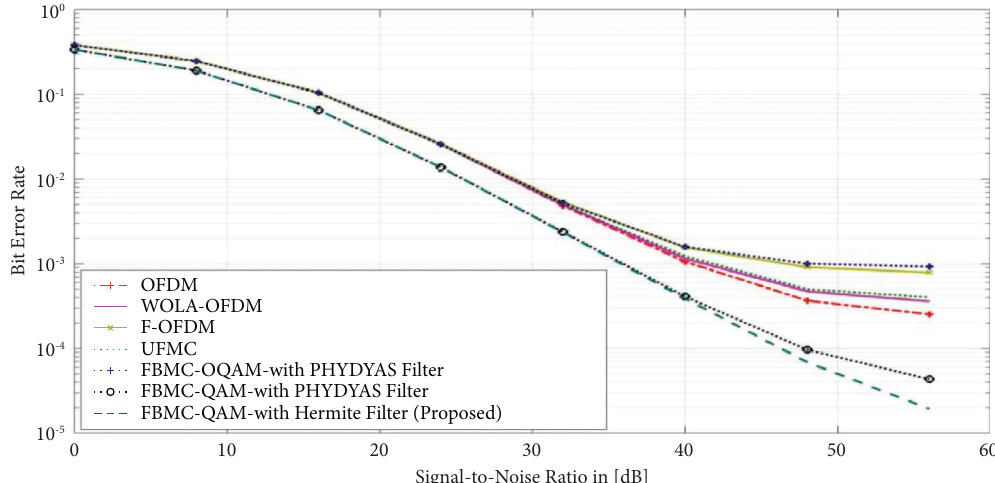
Figure 9: Bit error rate performance of diferent multicarrier modulation techniques for vehicular A channel model at 64 QAM.